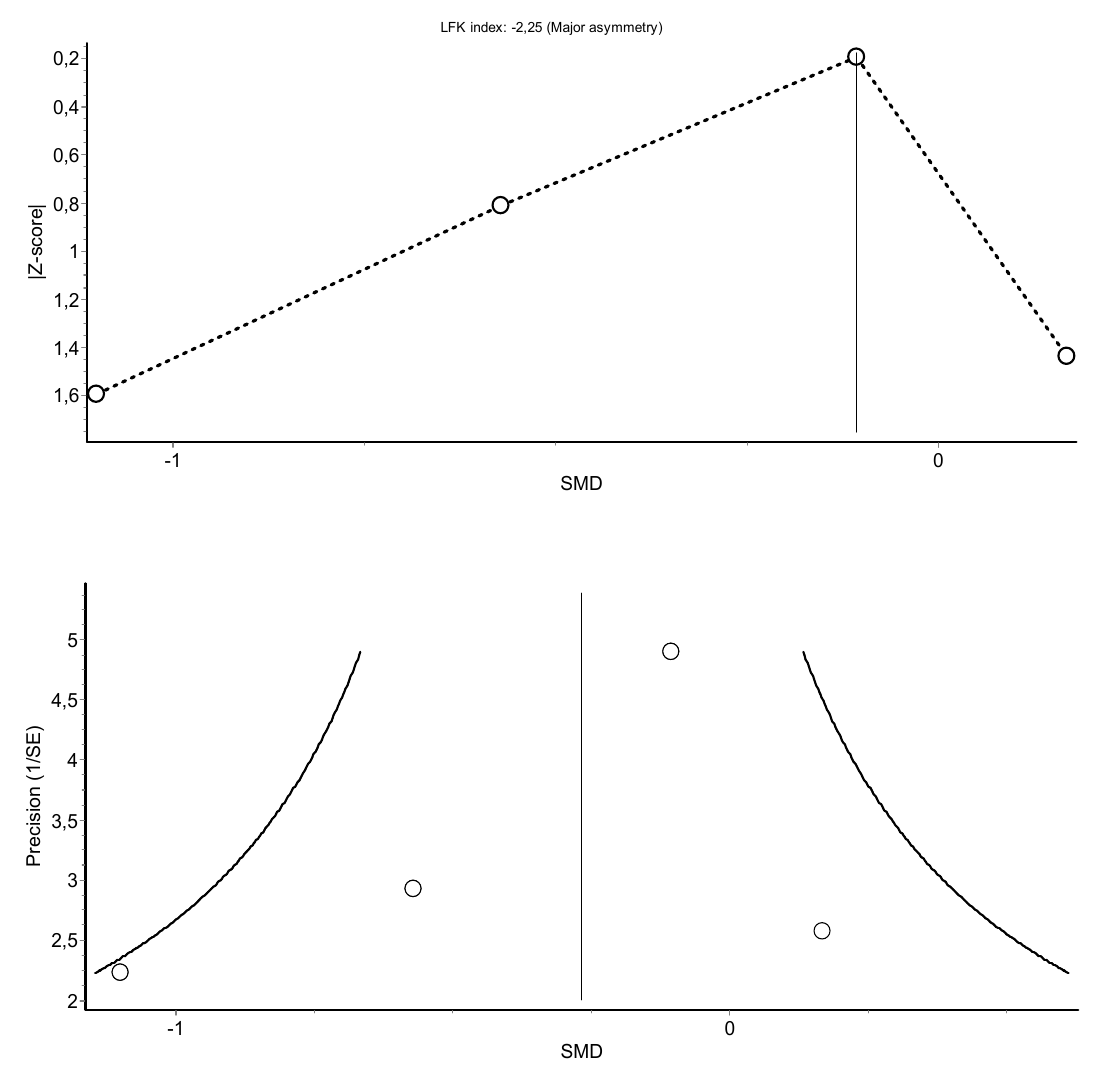
Figure A7. Synthesis funnel and Doi plot (LFK index) for body weight.